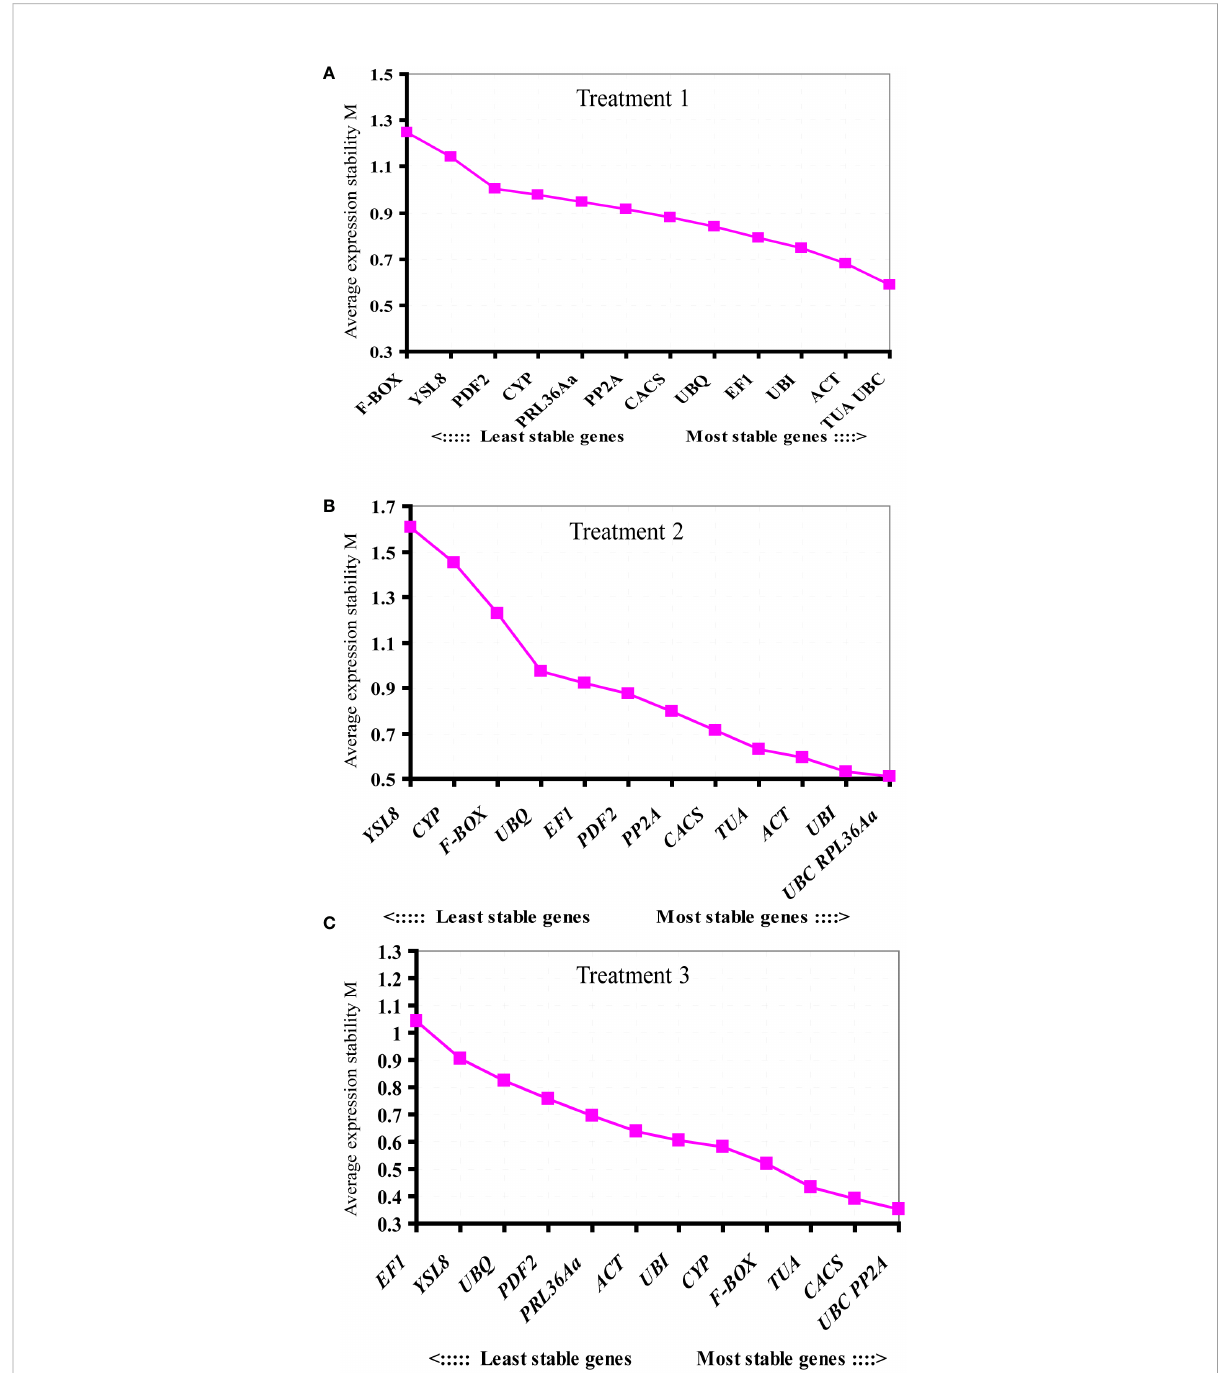
FIGURE 3 Ranking of the candidate reference genes according to geNorm analysis. The M value showing gene expression stability was calculated in three different treatments. (A) root knot treated by M. incognita (Treatment 1), (B) whole root treated by M. incognita (Treatment 2), and (C) whole root treated by Pseudomonas (Treatment